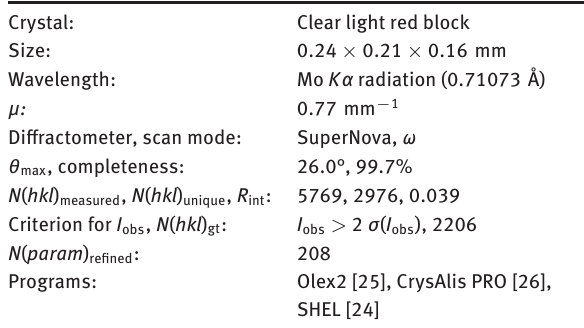
Table 1: Data collection and